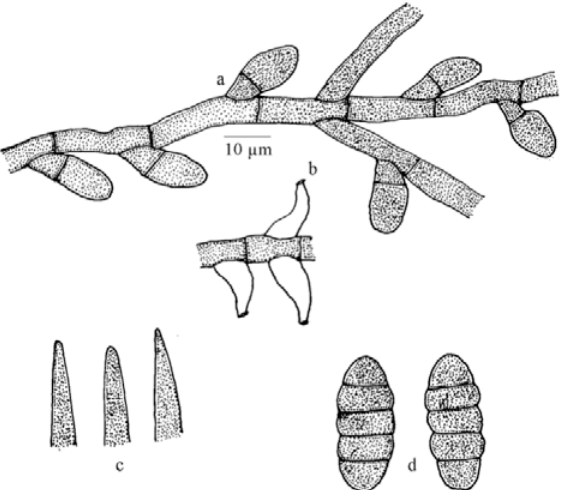
Figure 112. Meliola quadrispina a - Appressorium; b - Phialide; c - Apical portion of mycelial setae; d - Ascospores